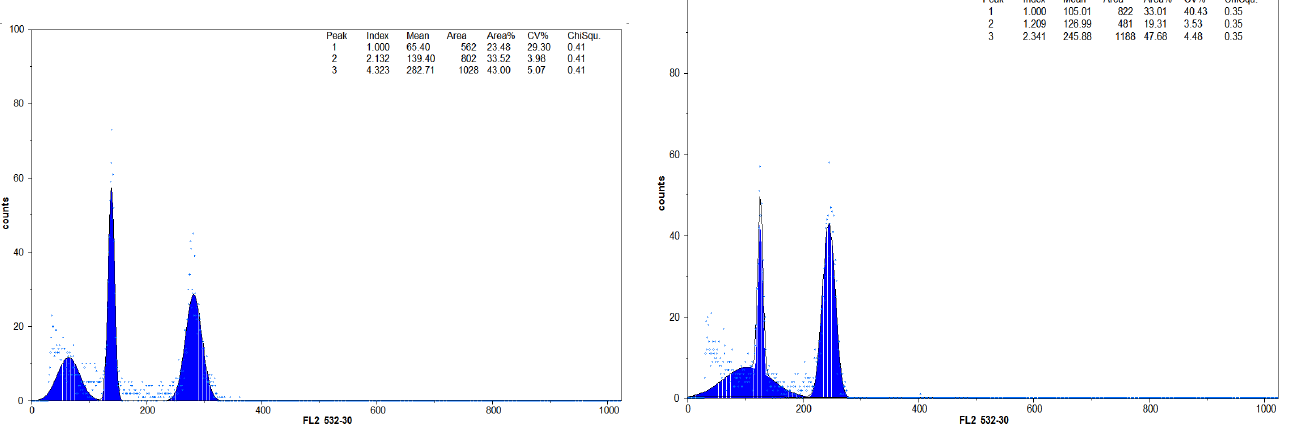
Fig. 3: Relative positions of the G1 peaks of ‘Azman’ banana clone and rice (fırst peak)